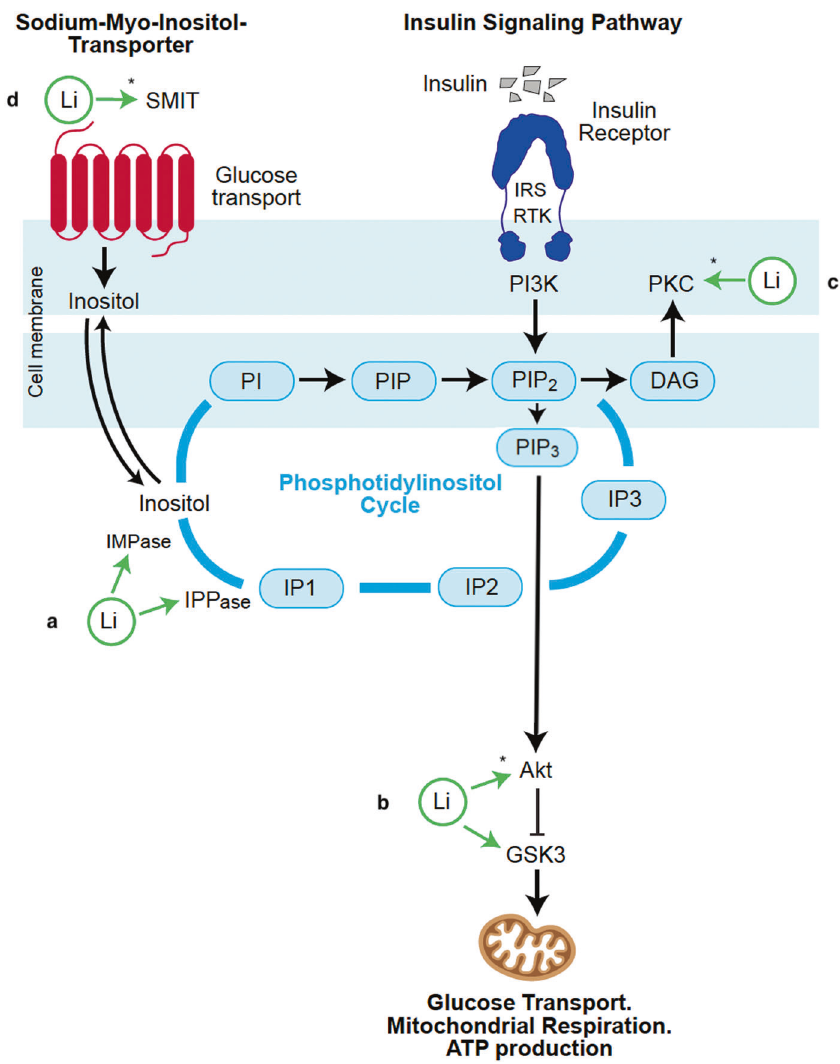
Fig. 1 Direct and indirect targets of lithium which play a role in the PI3K/Akt insulin signaling pathway. a IMPase and IPP in the PI-Cycle. Lithium inhibits the activity of the PI-cycle in 2 areas: inositol monophosphatase (IMPase) and inositol polyphosphate-1-phosphatase (IIPase), thereby limiting the turnover rate of PIP2 available for PI3K signaling. b GSK3. Lithium inhibits GSK3 directly through uncompetitive inhibition of binding of the GSK3 cofactor magnesium and indirectly through activation of Akt. c PKC. Lithium acts to inhibit PKC translocation from the cytosol to the cell membrane. d SMIT. Lithium indirectly inhibits the activity and expression of SMIT, possibly through primary effects on the PI-Cycle. Li with an asterisk (*) indicates an indirect target of lithium. Li Lithium, IRS insulin receptor substrate, RTK tyrosine kinase adapter molecules, DAG diacylglycerol, PKC protein kinase C, SMIT sodium myo-inositol transporter, IMPase inositol monophosphatase, IPPase inositol polyphosphatase, IP1 inositol (1) phosphate, IP2 inositol bisphosphate, IP3 inositol (1,4,5) triphosphate, PI phophotidylinositol,